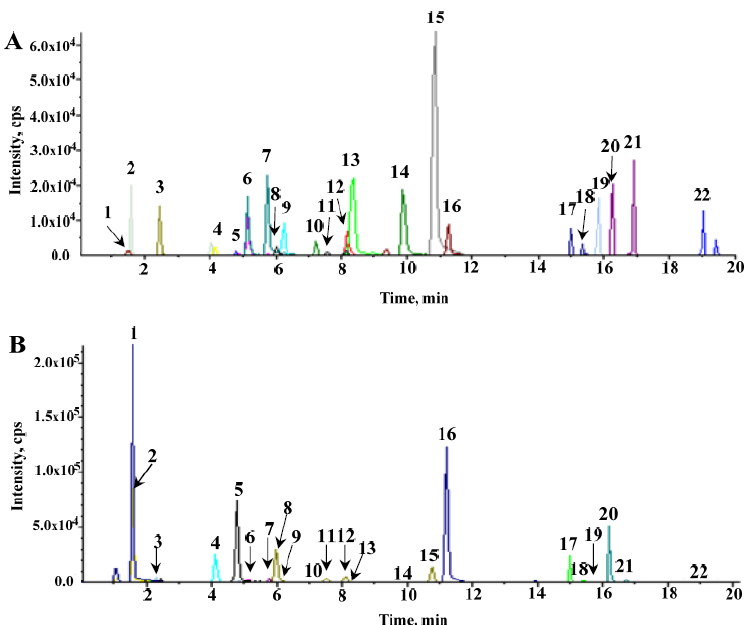
Figure 2. UPLC-MRM-MS TIC of reference standards ( A ) and the hairy root of American ginseng ( B ).